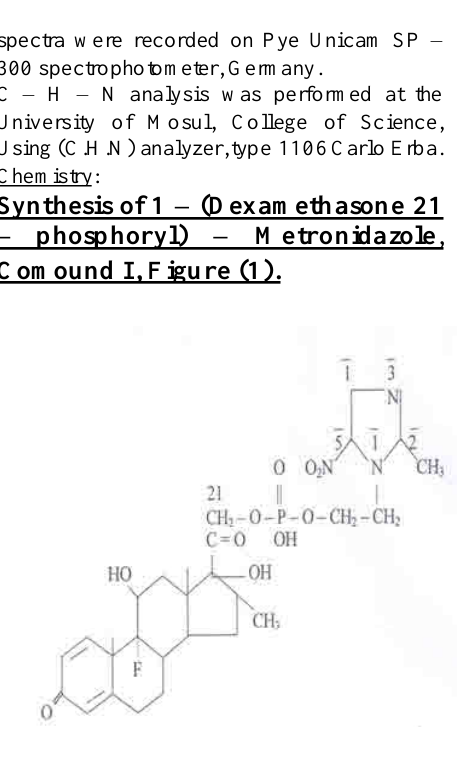
Fig.1 chimical structure of compound